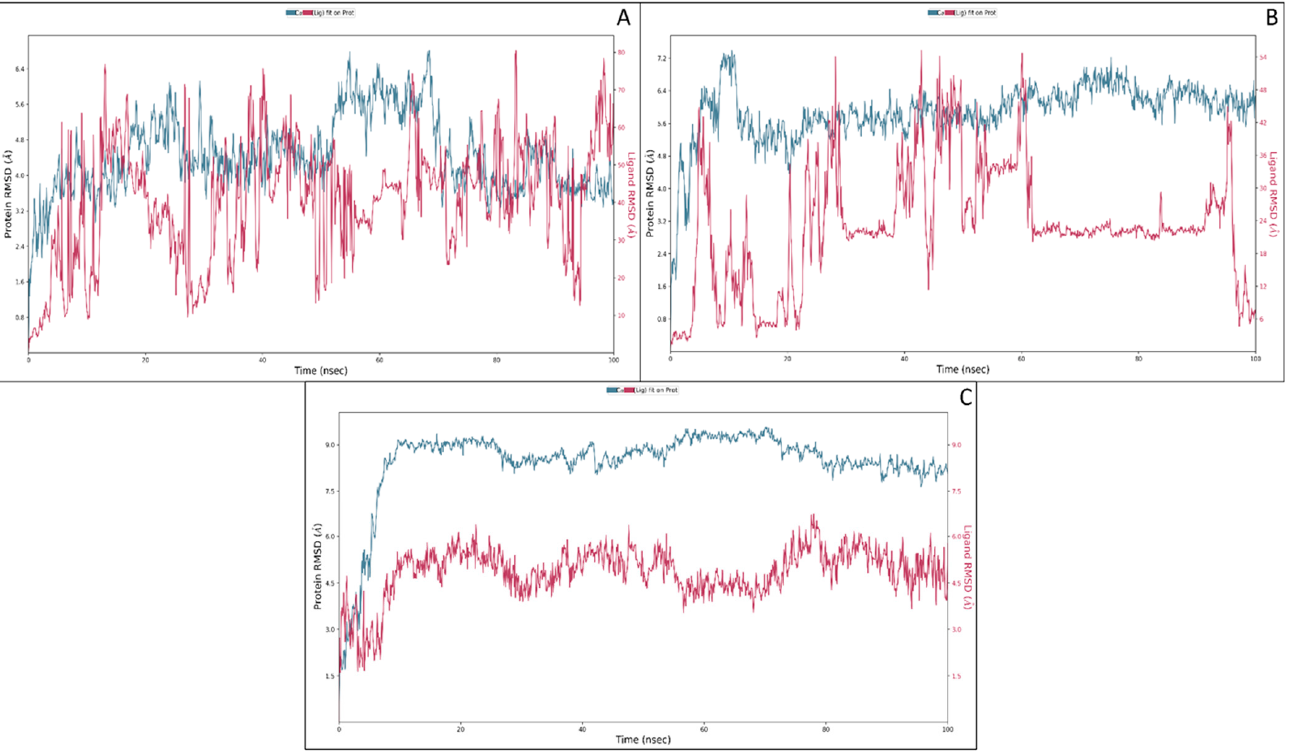
Figure 5. The root mean square deviation of the macrophage mannose receptor and ( A ) mannose, ( B ) PLGA, and ( C ) punicalagin.